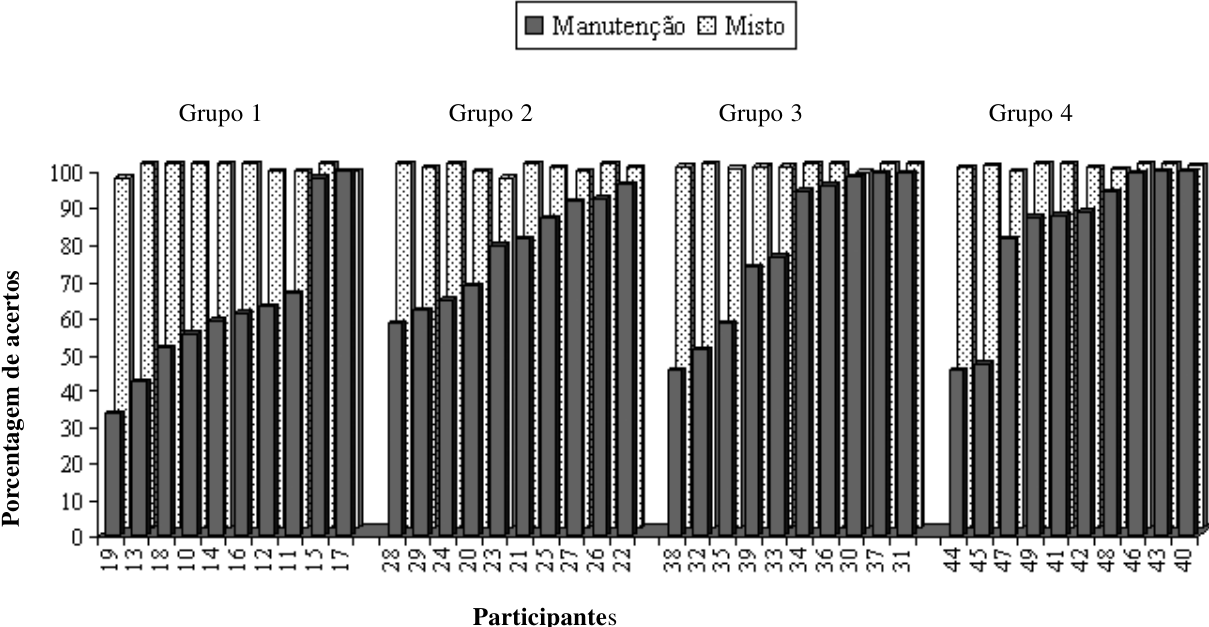
Figura 1 . Porcentagem de acertos dos participantes no Teste Misto e no Teste de